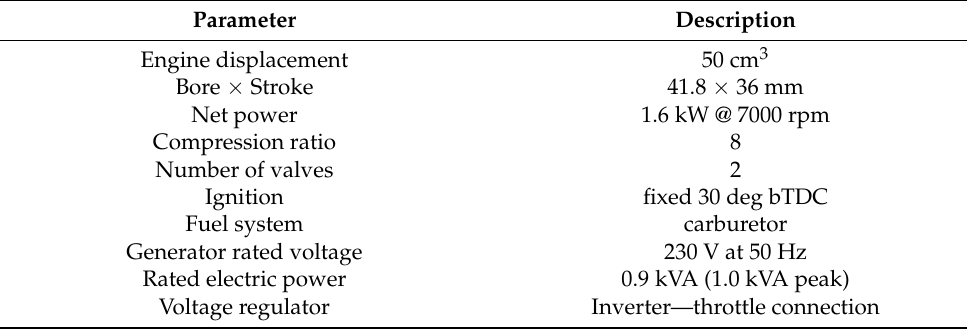
Table 1. Engine and generator